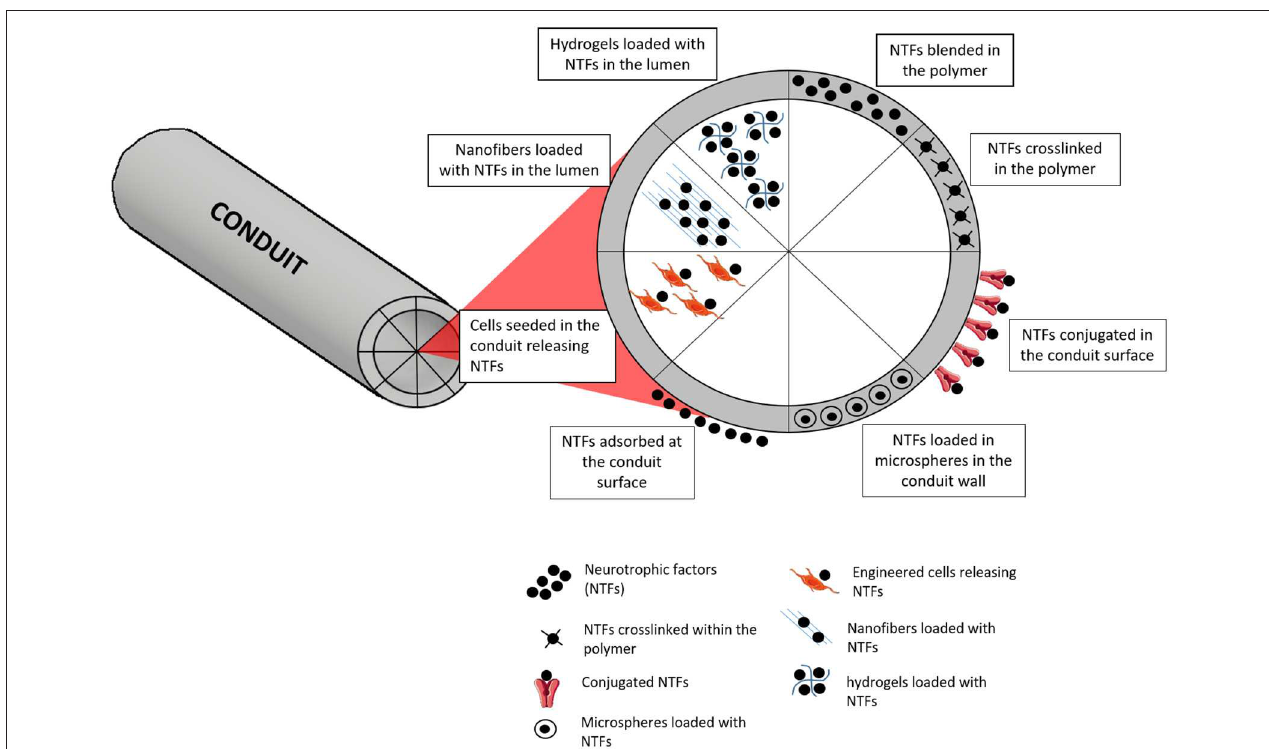
FIGURE 7 | Different strategies for incorporation and delivery of GFs from NGCs. One of the simplest approaches is based on simply blending the NTFs on the polymer, with or without further crosslinking of the polymer. Microspheres containing NTFs can also be blended in the polymer. At the surface, NTFs can be found just after an adsorption process or conjugated with other molecules for stronger entrapment or covalent links. When considering the delivery of NTFs from the lumen, several approaches can be followed, such as using engineered cells, nanofibers or hydrogels capable of loading and releasing the